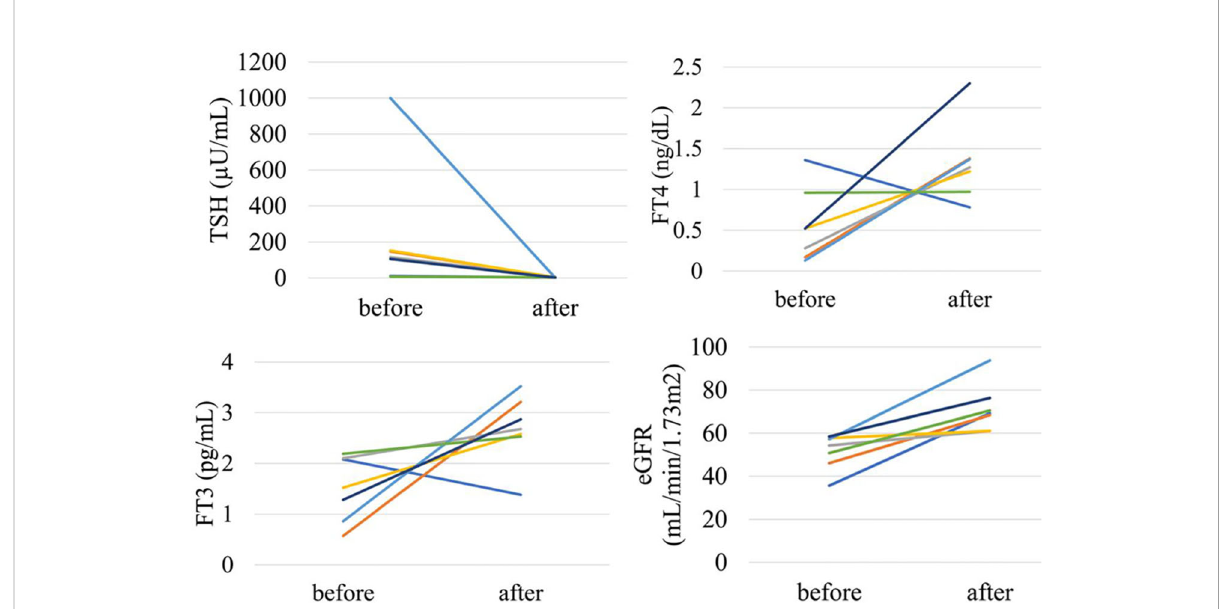
FIGURE 5 Changes in kidney and thyroid function before and after treatment in “ reversible ” CKD patients in